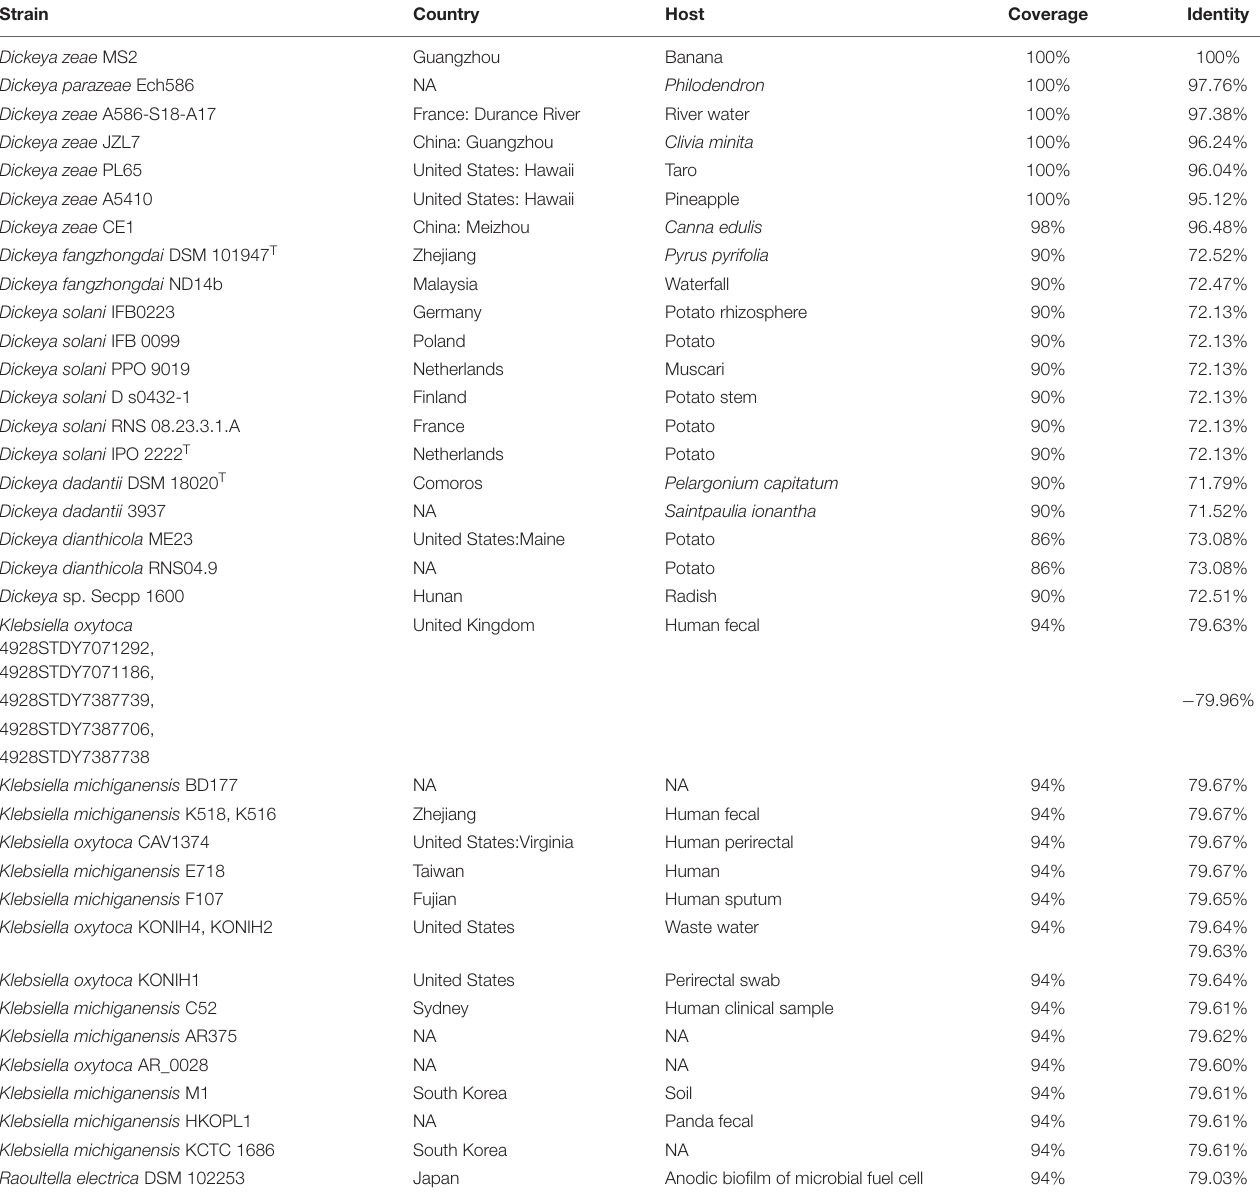
TABLE 1 | Homologs of the luxR -solo systems ( C1O30_RS14500 to C1O30_RS14535 ) of Dickeya zeae MS2.